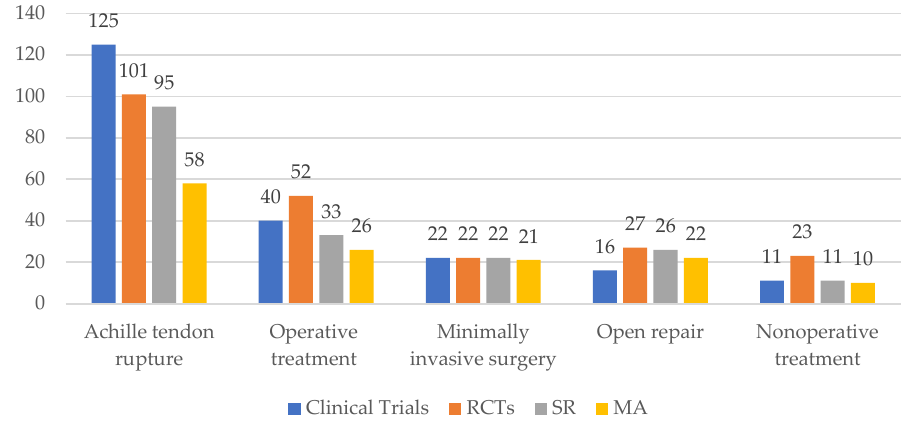
Figure 2. Citations metrics for type of study. Graphic legend: RCT = randomized clinical trials; SR = systematic review; MA = metanalysis.